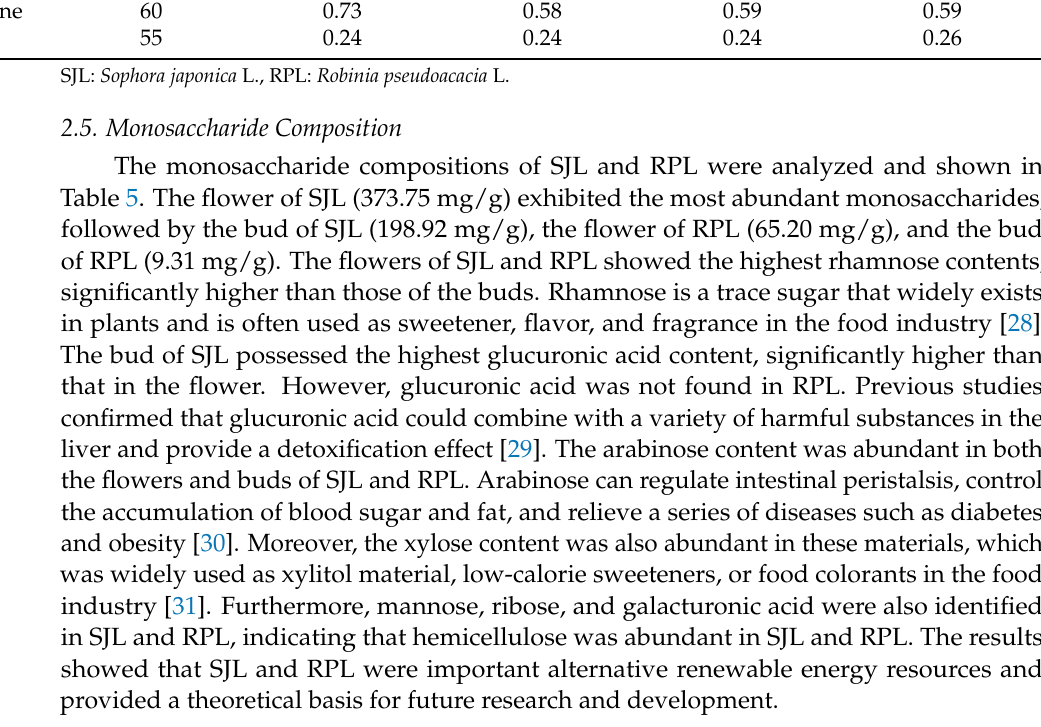
Table 5. Identification of monosaccharide compounds of SJL and RPL (mg/g dw). Compound Flower of SJL Bud of SJL Flower of